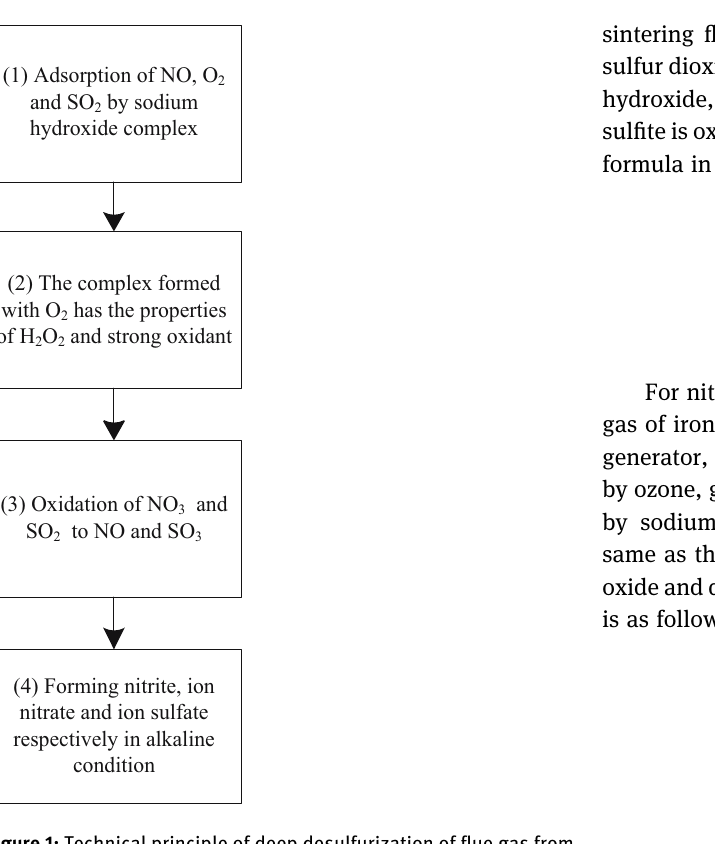
Figure 1: Technical principle of deep desulfurization of fl ue gas from low - temperature oxidation sintering of ethylenediamine